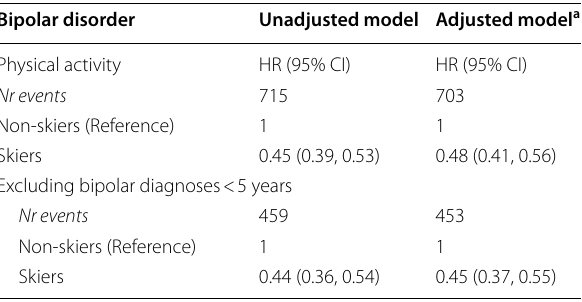
C ox regression models showing HR for risk of bipolar disorders a Model adjusted for age, sex, and education